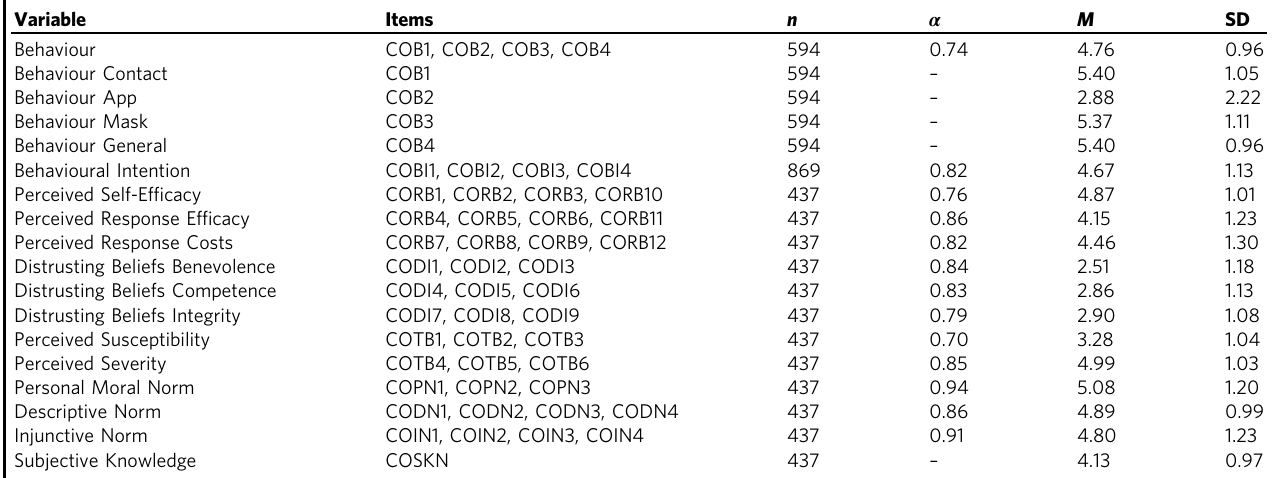
Table 4 Descriptive statistics for the variables considered in the additional analysis: Number of observations n , Cronbach ’ s α , means M and standard deviation SD. All scales range from 1 to 6, with Perceived Response Costs inverted.